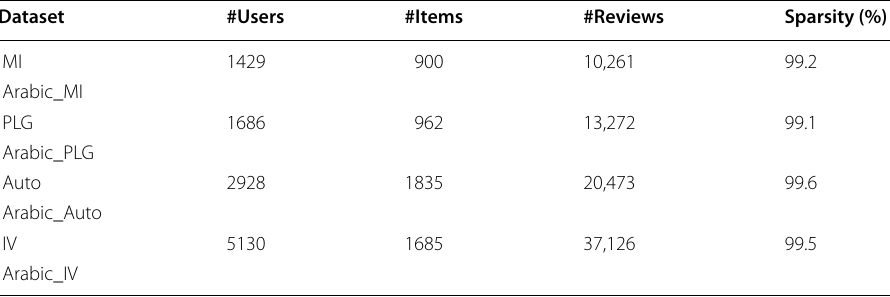
Table 1 Statistical details of the datasets